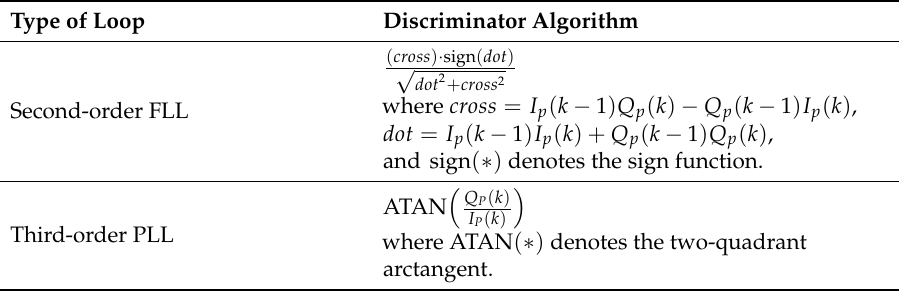
Table 1. Discriminators that are used in the FLL-assisted-PLL carrier tracking